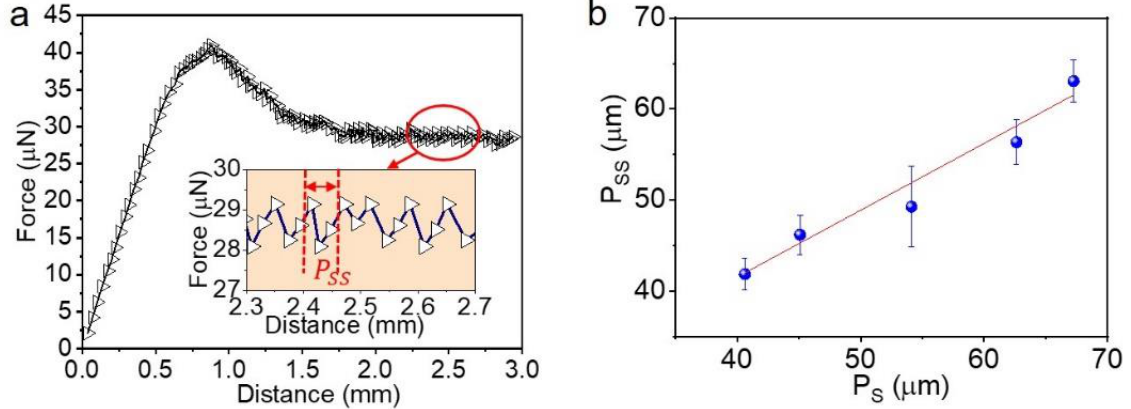
Figure 6. Stick-slip motion during kinetic friction. ( a ) Typical pattern of stick-slip, inset shows the definition of period of stick-slip (P ss ); ( b ) Dependence of P ss on the period on ATM along the stretching direction (P S ).